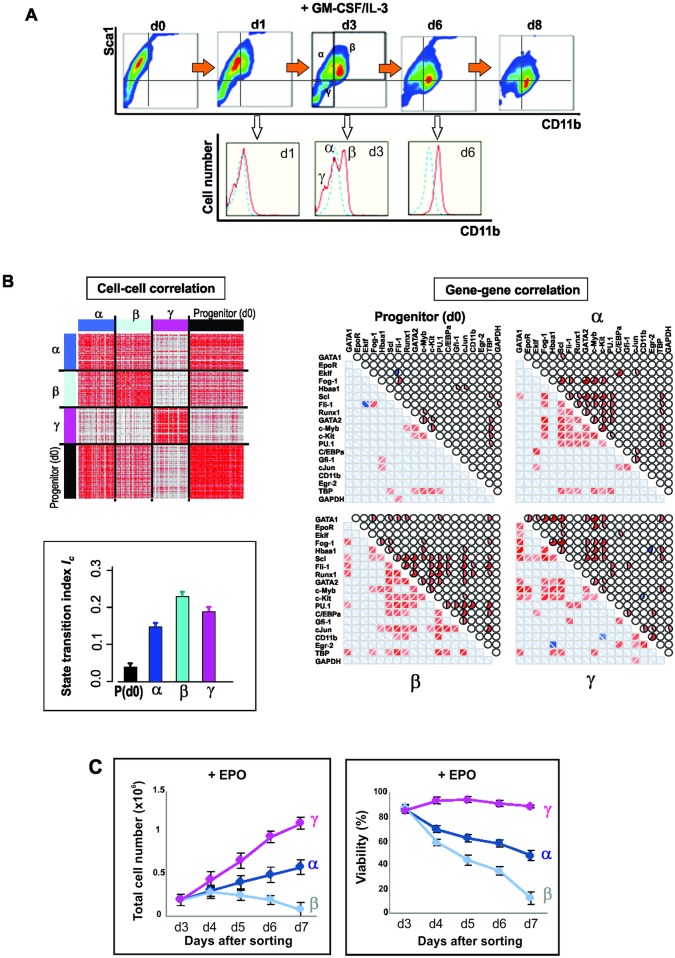
Intermediate stage of myeloid commitment along CD11b dimension exhibits destabilization of progenitor state.(A) Flow cytometry dot plot of expression of Sca1 and CD11b upon treatment of the progenitor EML cells with GM-CSF/IL-3. Three distinct subpopulations on d3, designated, α, β and γ, in the tri-modal distribution of CD11b flow cytometry histogram underneath (red line, treated; blue line, untreated). (B) Cell–cell correlation for 72 progenitor cells and 48 cells from each of the α, β, and γ subpopulations, and gene–gene correlation for all 17 genes of interest and two endogenous control genes. Pearson correlation coefficient displayed as heatmap; same color scheme as in Fig 2. Bar graphs in box show the drastic increase of IC for all the three subpopulations at d3 compared to the untreated progenitor cells, P(d0). IC computed as in Fig 1. (C) Rescue by EPO of the “rebellious” = unintended γ subpopulation (pink curve) during myeloid differentiation. Three subpopulations (α, dark blue; β, light blue; γ, pink) were FACS sorted and antibodies were removed and stimulated with EPO. Total cell number and viability were quantified on day of sorting (d3) and four subsequent days. Viability was determined based on percent of cells excluding trypan blue. Each point represents average +/- STD for two biological replicates.